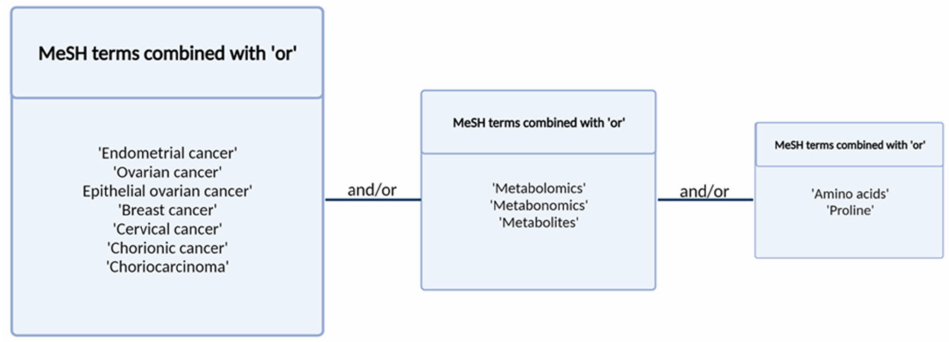
Figure 3. Search terms and strategy.